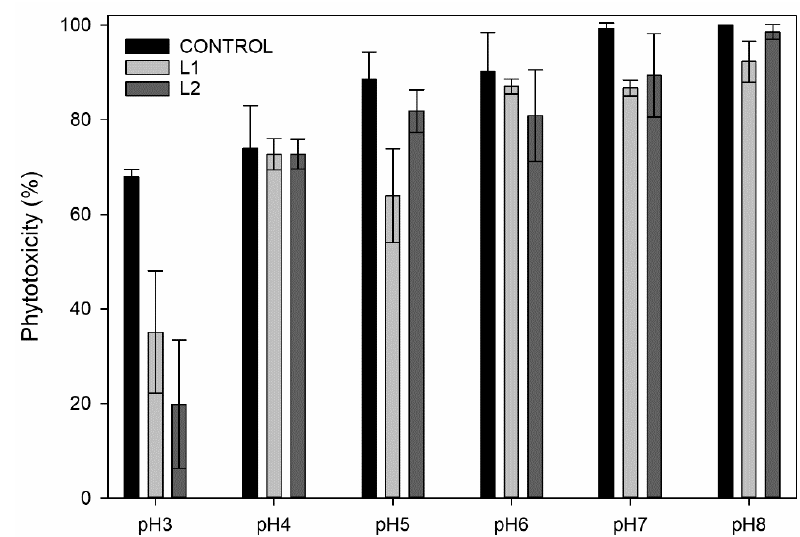
Figure 14. Percentage of phytotoxicity of the untreated and treated dye baths carried out at different pHs.